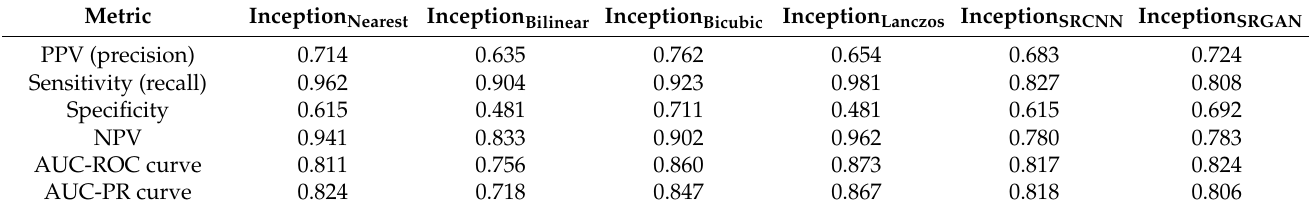
Table 7. Test results for each Inception